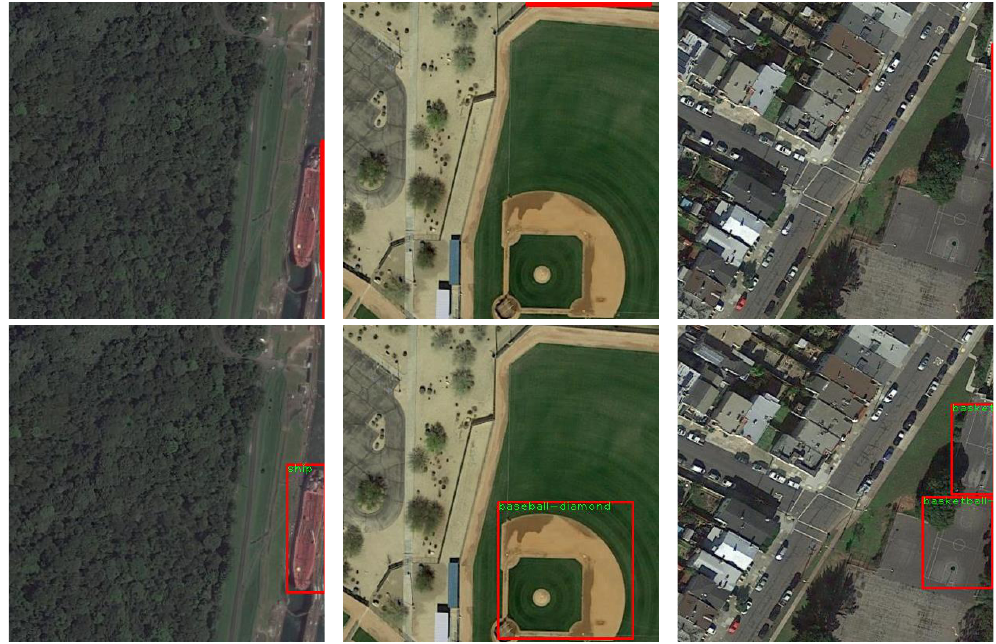
Figure 4. Illustration of lines like false region proposals (LFRP, the first row) generated by classic deformable